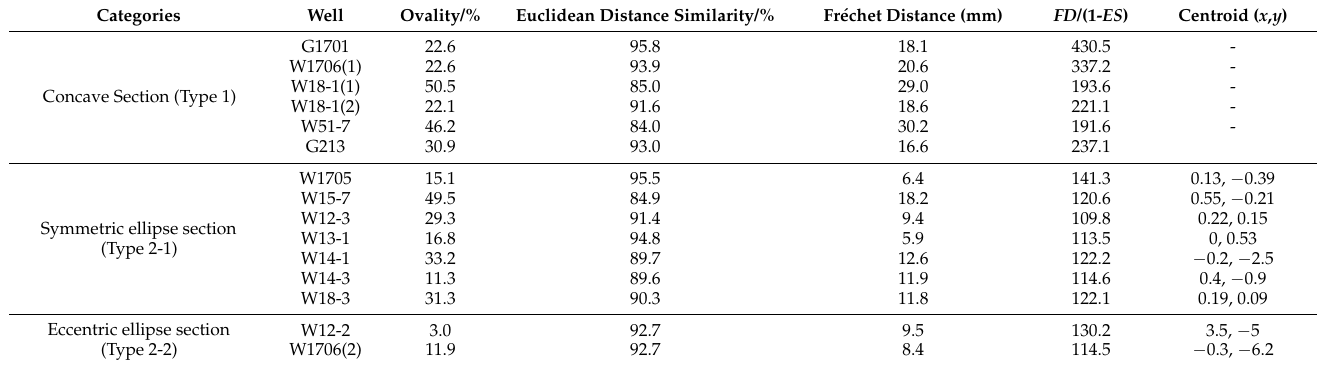
Table 1. Geometric characterization of casing deformation in Weiyuan and Guandong oil